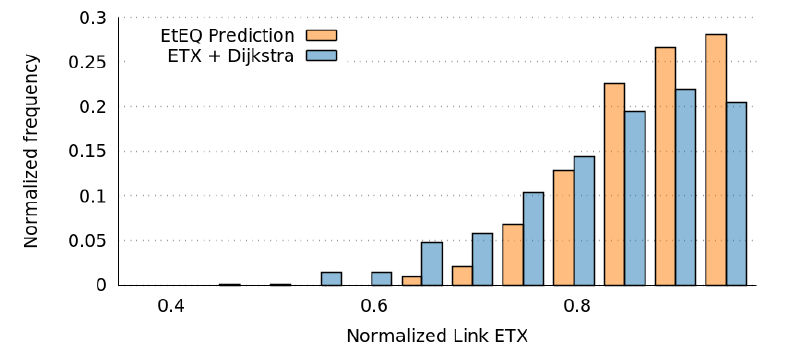
Figure 22. Histogram of the ETX of links.